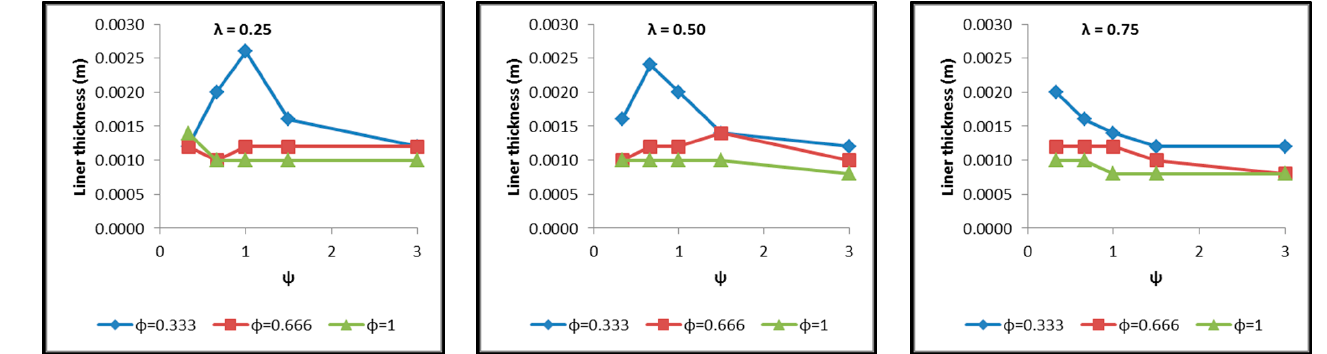
Figure 19. Distribution of the required insulating material mass for maintaining the boil-off rate at 0.1%/hr as a function of the ratios λ , φ and ψ .